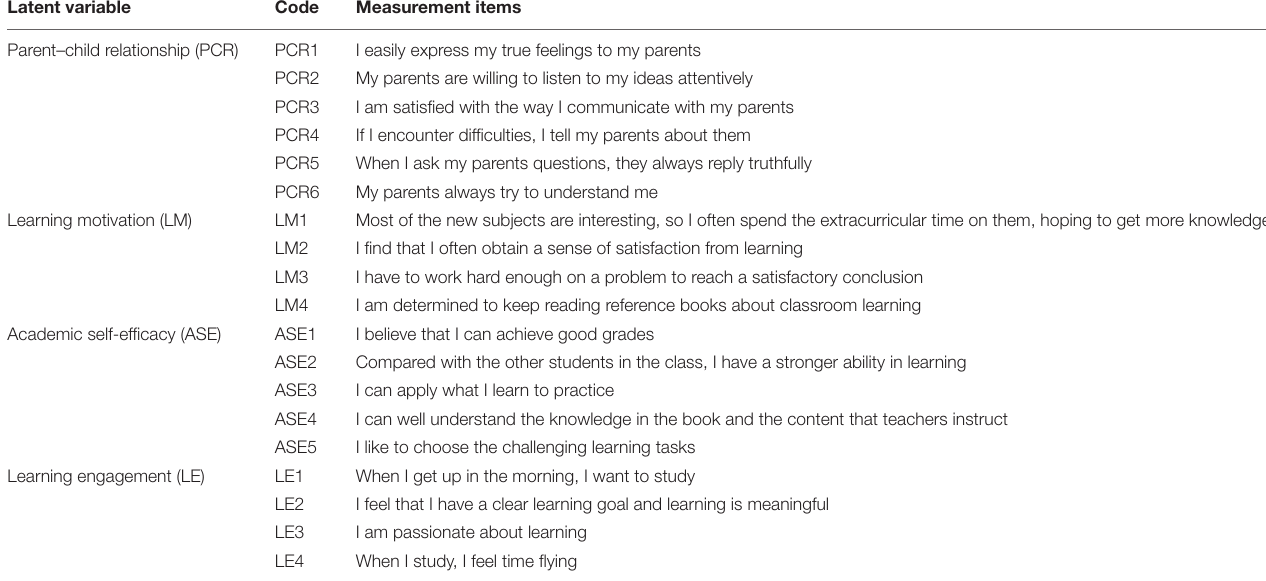
TABLE 1 | Latent variables and items.